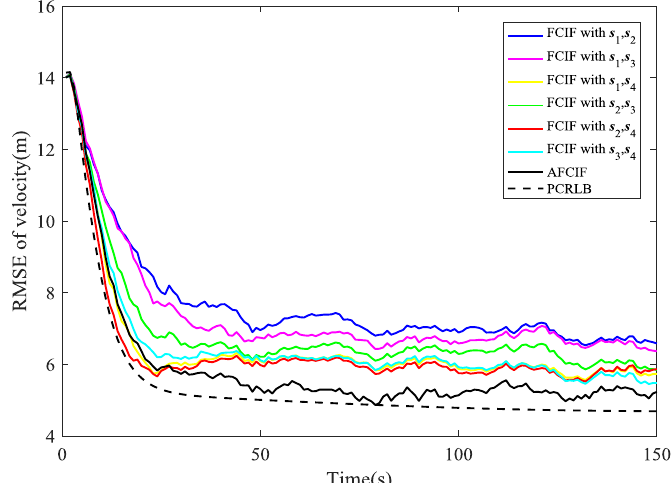
Figure 4. Comparison of RMSE (position estimation) when the initial process noise covariance is set to be smaller than the true value.